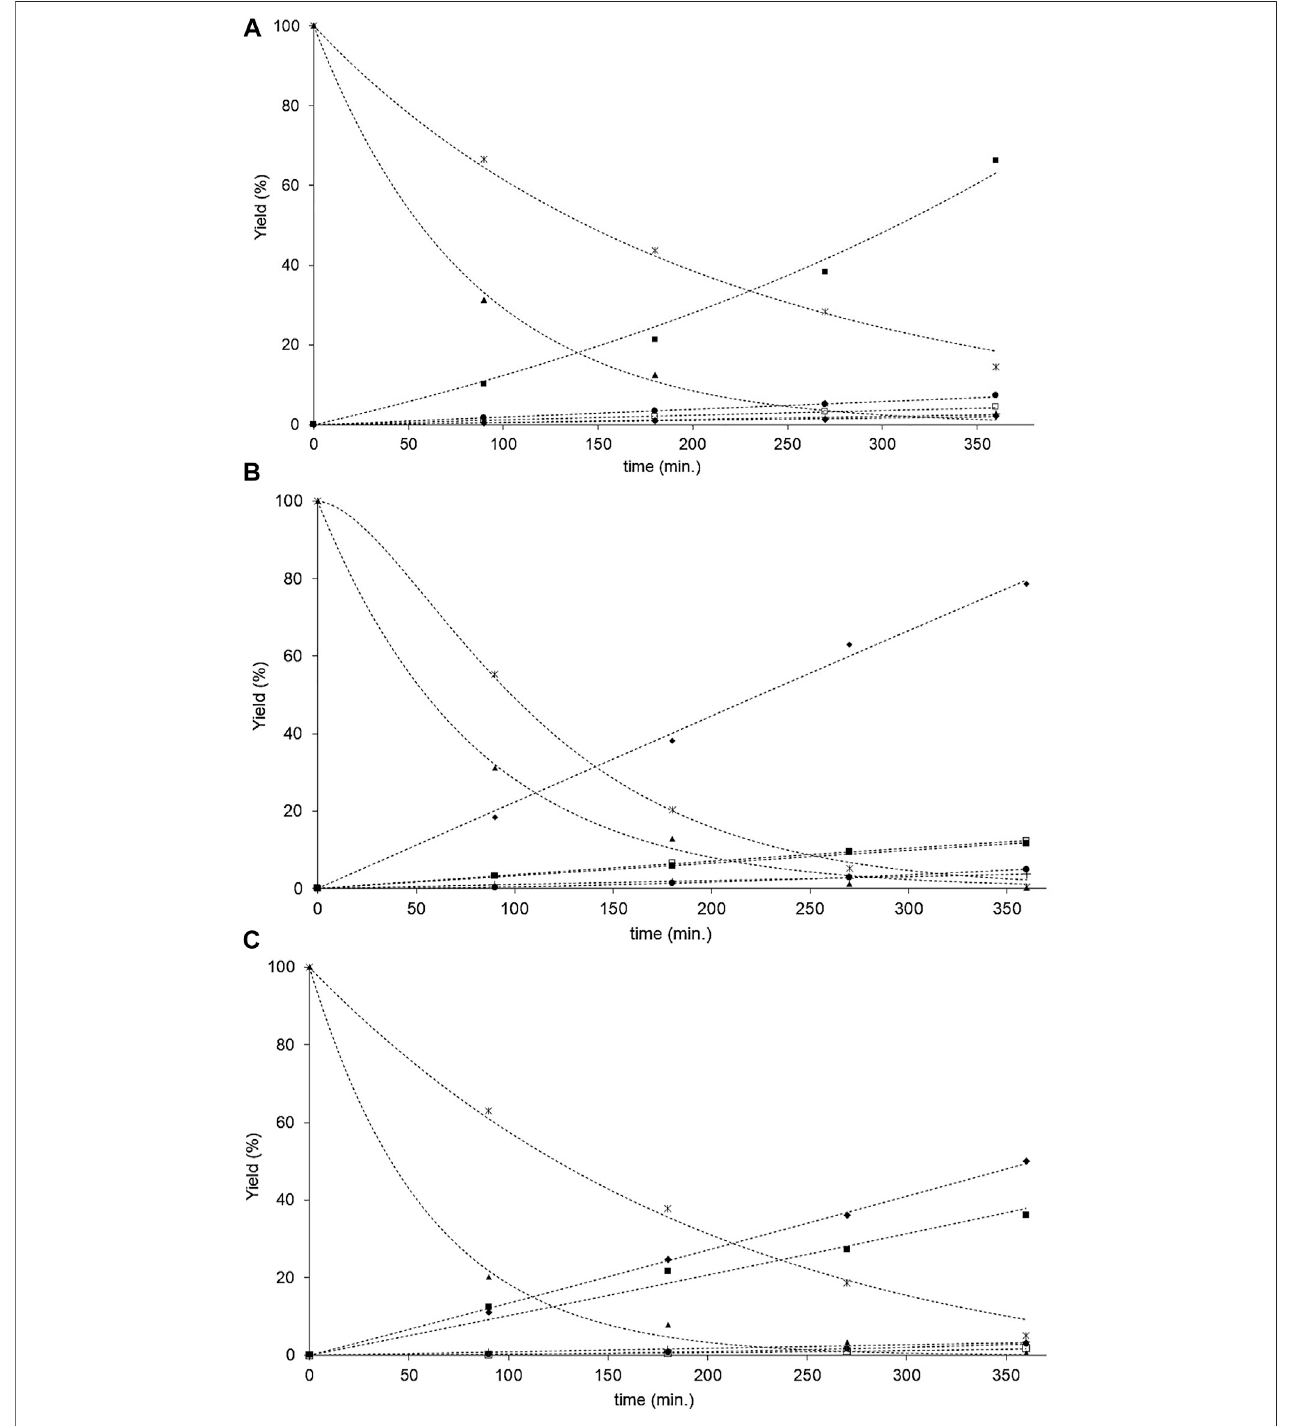
FIGURE 7 | (A) The oleic and stearic acids HYD activities in function of reaction time over the NiP-S/ γ -Al 2 O 3 -MgO catalyst. ( ▲ ) Oleic acid, ( h ) stearic acid, ( □ ) 8- (cid:129) octadecene, ( ■ ) heptadecane, ( ◆ ) octadecane, (+) light HC, and ( ) 8-methyl, 8-heptadecene. (---) predicted value. (B) The oleic and stearic acids HYD activities in (cid:129) function ofreaction time over theMoP-S/ γ -Al 2 O 3 -MgO catalyst. ( ▲ ) Oleicacid,( h ) stearic acid, ( □ ) 8-octadecene, ( ■ ) heptadecane, ( ◆ ) octadecane, (+) light HC,and ( ) 8-methyl, 8-heptadecene. (---) predicted value. (C) The oleic and stearic acids HYD activities in function of reaction time over the NiMoP-S/ γ -Al 2 O 3 -MgO catalyst. (cid:129) ( ▲ ) Oleic acid, ( h ) stearic acid, ( □ ) 8-octadecene, ( ■ ) heptadecane, ( ◆ ) octadecane, (+) light HC, and ( ) 8-methyl, 8-heptadecene. (---) predicted value.